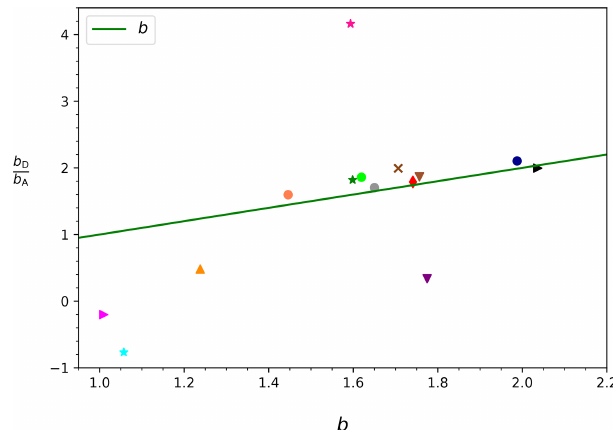
Figure 9. Ratio of the coefficients b D and b A from fits ( M b ) to v vs. D max and v vs. A relationships, respectively, and the coefficient b corresponding to the A vs. D max relationship are shown for all the shape groups. The solid green line corresponds to b D